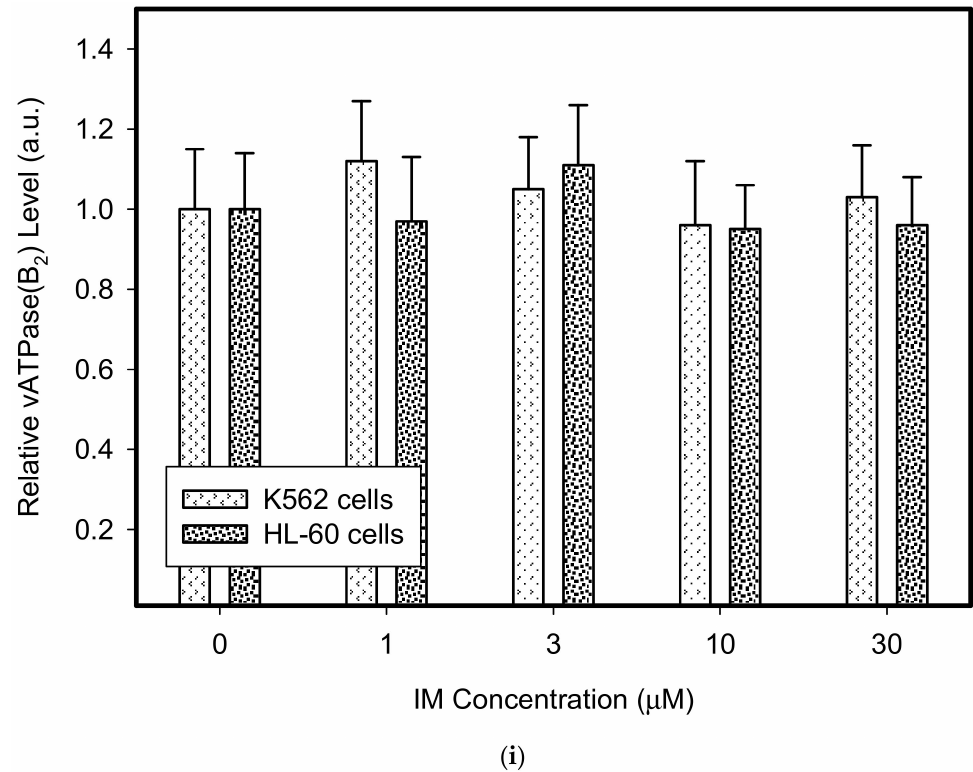
Figure 3. E ff ect of IM on expression of lysosomal proteins in cancer cells. Cells were cultured for 6 h in the presence of IM as indicated prior to Western blot analysis. Cells cultured in medium without IM were taken as a control. ( a ) Western blot analysis of LAMP1 in K562 cells (typical analysis). ( b ) Western blot analysis of LAMP1 in HL-60 cells (typical analysis). ( c ) Quantitative analysis of LAMP1 expression using densitometry. ( d ) Western blot analysis of LAMP2 in K562 cells (typical analysis). ( e ) Western blot analysis of LAMP2 in HL-60 cells (typical analysis). ( f ) Quantitative analysis of LAMP2 expression using densitometry. ( g ) Western blot analysis of vacuolar ATPase subunit B2 in K562 cells (typical analysis). ( h ) Western blot analysis of vacuolar ATPase subunit B2 in HL-60 cells (typical analysis). ( i ) Quantitative analysis of vacuolar ATPase subunit B2 using densitometry. Results were normalized to β -actin. The results represent the means of four independent experiments with standard